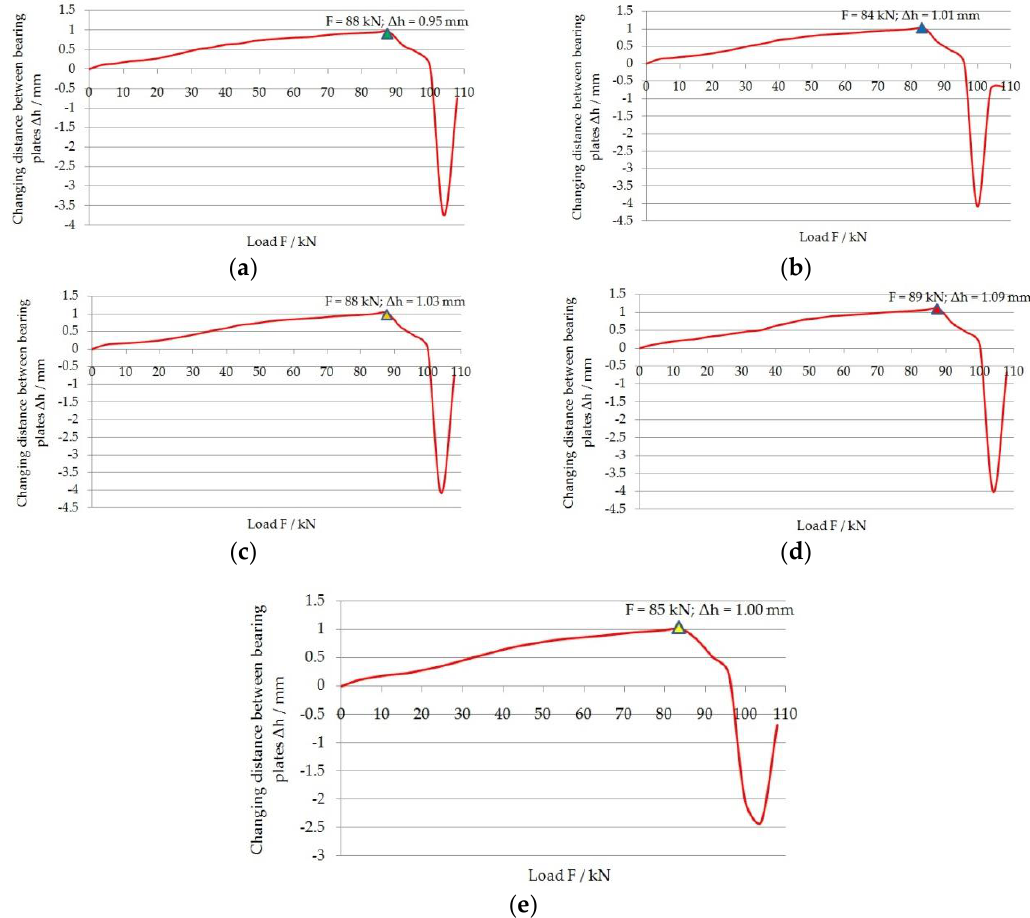
Figure 9. Calibration of the mechanical force sensor of the expansion rock bolt: (a) Bolt no 1; (b) Bolt no 2; (c) Bolt no 3; (d) Bolt no 4; (e) Bolt no 5.